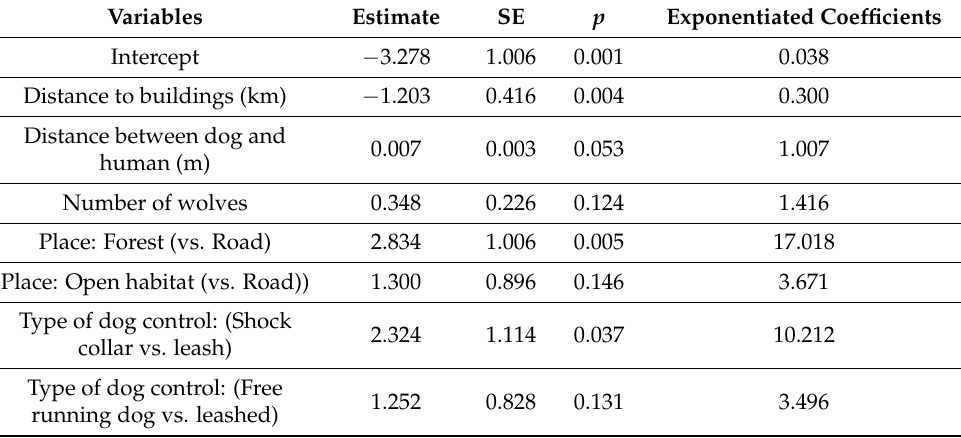
Table 3. Average parameter estimates for binomial GLM explaining the occurrence of dog–wolf interactions (multiple variable model) AIC: